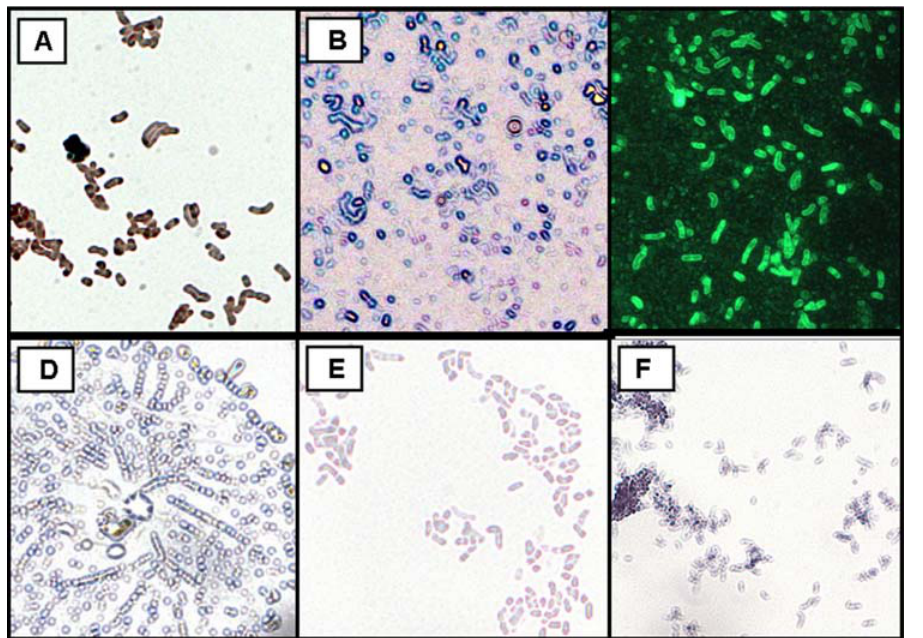
Figure 3. Smears of bacteria processed by ISH and FISH using biotin-labeled probe specific for H.pylori16SrRNA (1,000X). H. pylori isolate processed by ISH and using biotin-labeled probe specific for H. pylori 16S rRNA (A; avidin peroxidase-DAB; brown; and B; avidin alkaline phosphatase BCIP/NBT; blue) or by FISH [C; avidin- fluorescein (FITC) stained green]. Negative controls (light violet stain due to the hematoxylin QS counterstaining but no brown or blue reaction): ISH using biotin-labeled probe specific for H. pylori 16S rRNA (avidin- peroxidase-DAB; negative) in a strain of S. typhimurium LT2 (D). Negative controls of methods using PBS (E) or scorpion toxin (F).